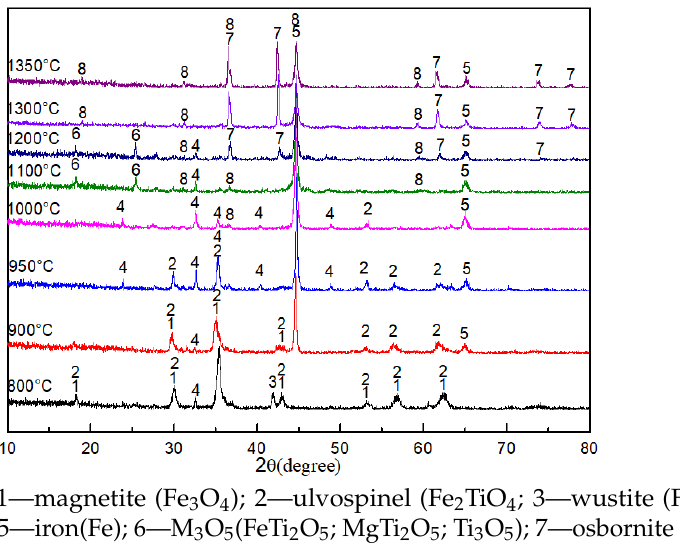
Figure 2. XRD patterns of pellets roasted at different temperatures for 90